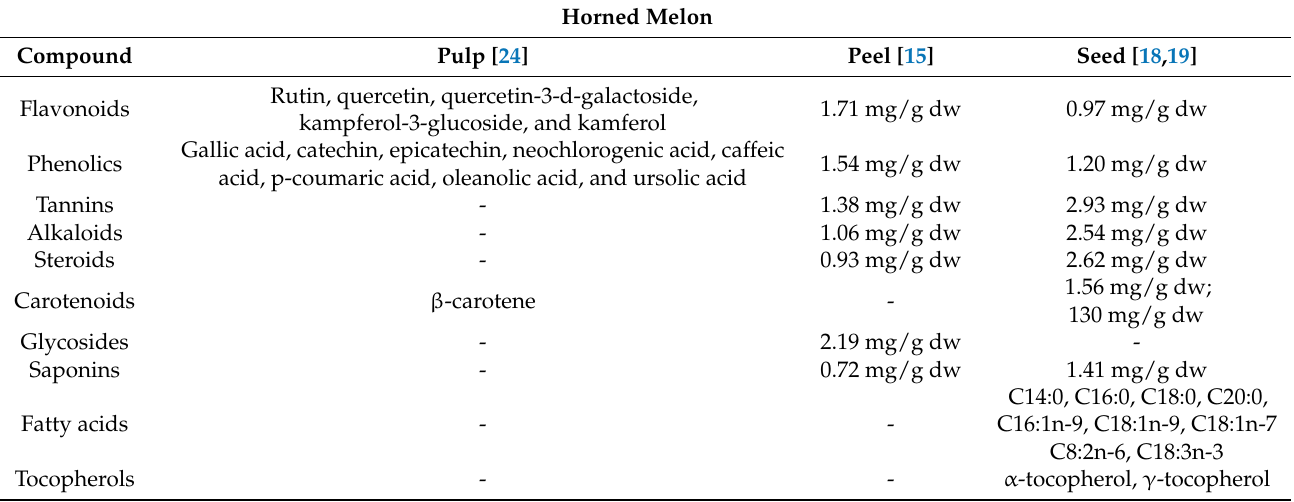
Table 3. Phytochemical composition of horned melon pulp, peel, and seed. dw—dry weight. Horned